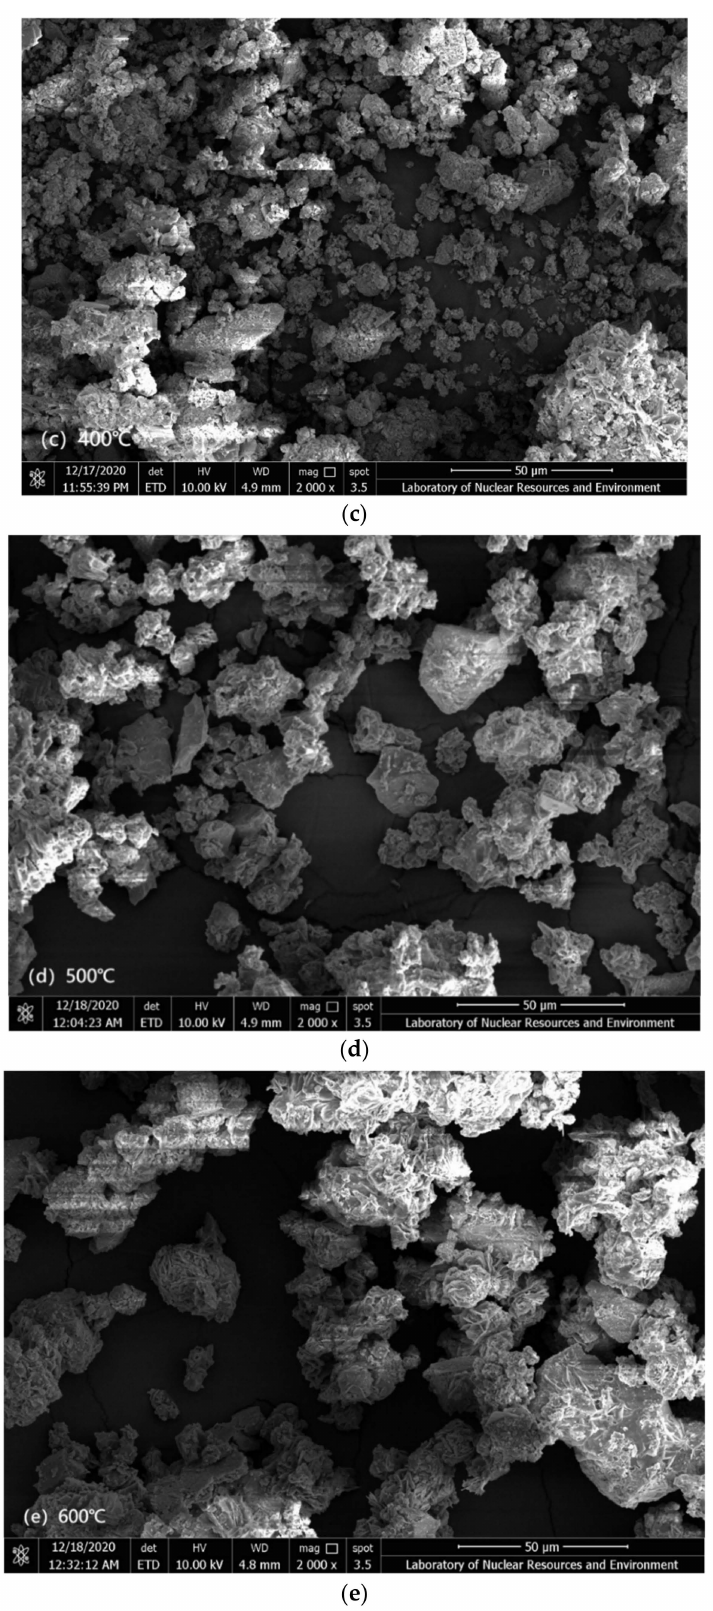
Figure 5. SEM images of tantalum-niobium slag roasted at ( a ) 200 ◦ C; ( b ) 300 ◦ C; ( c ) 400 ◦ C; ( d ) 500 ◦ C; ( e ) 600 ◦